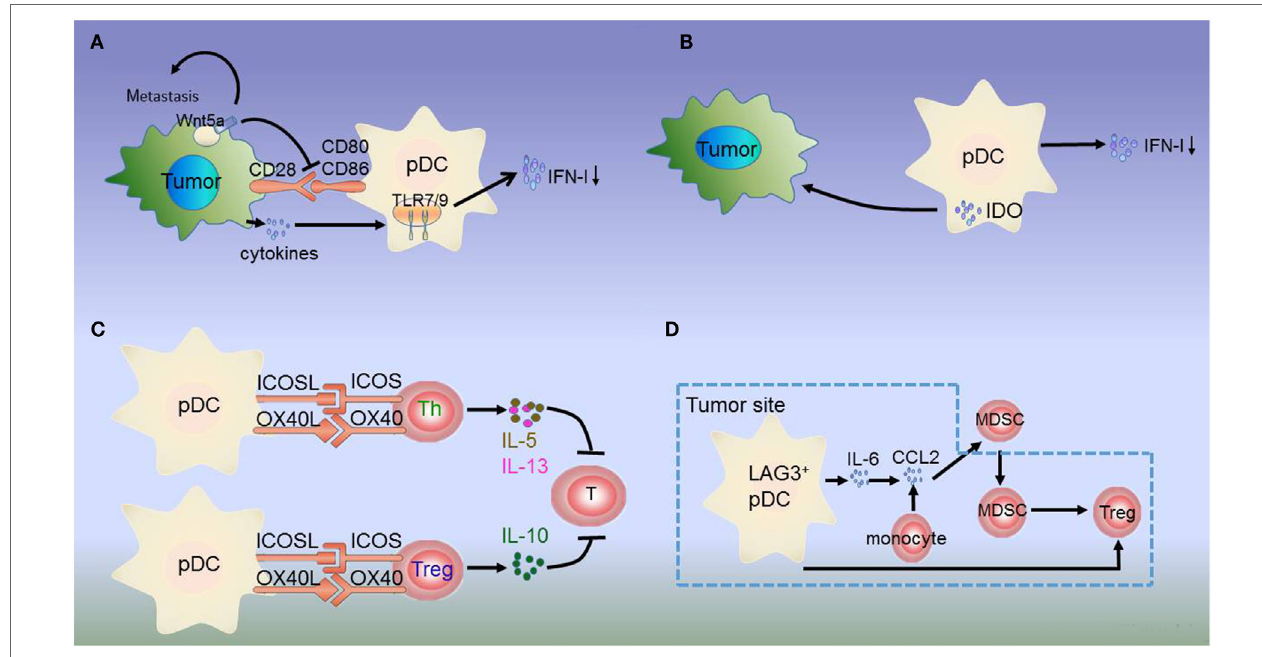
FigURe 1 | Dysregulation of plasmacytoid dendritic cells (pDCs) in melanoma. (A) Melanoma cells produce the immunosuppressive cytokines prostaglandin E2 (PGE2), interleukin-10 (IL-10), and transforming growth factor beta (TGF- β ), which directly suppress type I interferon (IFN-I) production by inhibiting toll-like receptor (TLR) expression on pDCs. Additionally, melanoma-associated pDCs express Wnt5a, which blocks the upregulation of the activation markers CD80 and CD86 on human pDCs and inhibits toll-like receptor (TLR)-mediated pDC activation and production. Wnt5a can also promote melanoma metastasis. This inhibits antitumor function depending on IFN-I. (b) IDO expression in pDCs promotes immune evasion by the tumor. (C) Resident pDCs trigger IL-5/IL-13-secreting Th2 cells and IL-10-secreting Tregs through OX40L/OX40 and ICOSL/ICOS interactions. These cytokines inhibit cytotoxic T cell function and directly favor melanoma growth. (D) LAG3 + pDCs produce IL-6 without inducing IFN-I. pDC-derived IL-6 induces the production of CCL2—a key chemokine in the recruitment of myeloid-derived suppressor cells (MDSCs)—at the tumor site. LAG3 + pDCs and migratory MDSCs induce Tregs directly. Thus, through this alternative activation, LAG3 + pDCs promote